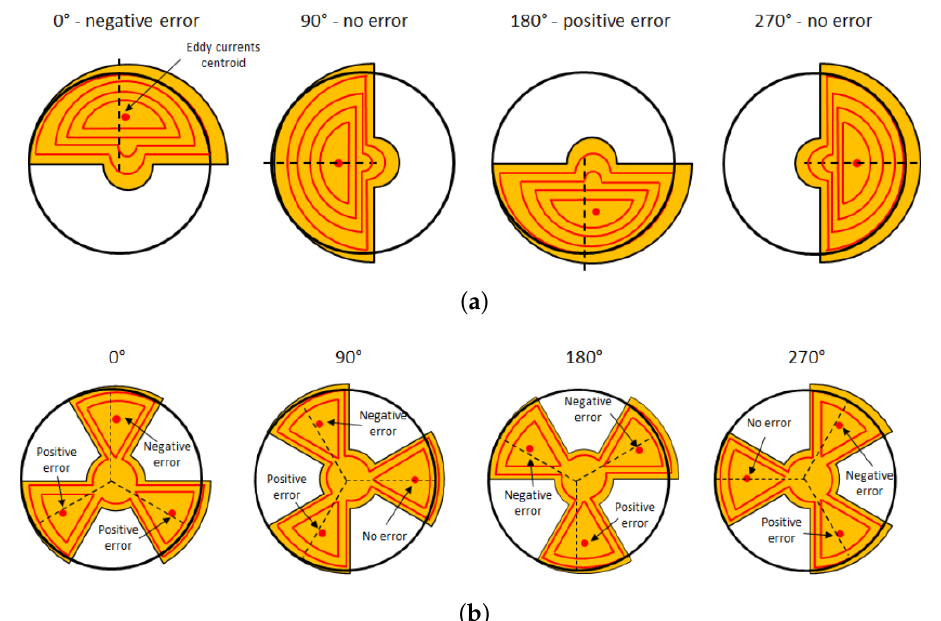
Figure 3. Centroid of the eddy currents for a slight off-axis shift for 4 rotation angles. The dotted line represents the ideal angular position. ( a ) Case of a 360 ◦ -capable sensor (periodicity = 1) with a half-moon target. The centroid is oscillating around its ideal rotating position, introducing a periodic error. ( b ) Case of a 120 ◦ -periodic sensor (periodicity = 3) with a three-lobe target. The three centroids are again oscillating, but there is a built-in